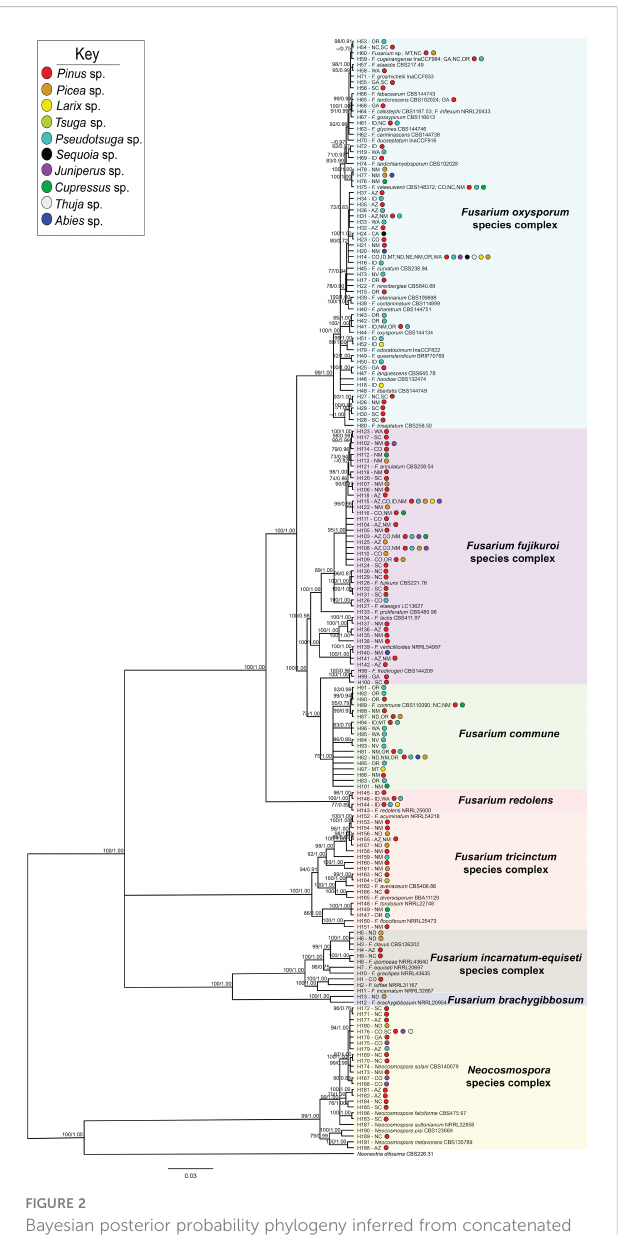
FIGURE 2 Bayesian posterior probability phylogeny inferred from concatenated tef1 a and rpb2 haplotypes from sequences of 325 Fusarioid fungi isolates collected from conifer hosts across the contiguous USA. Node values indicate maximum likelihood bootstrap support based on 1000 pseudo-replicates and Bayesian posterior probability values above 70%/0.75, respectively. The tree is rooted to Neonectria ditissima isolate sequences collected from GenBank (accession # tef1 a : JF735783.1; rpb2 : DQ789798.1). For each haplotype (denoted by H#), states are listed and colored circles indicate the host genera from which the isolates within that haplotype were collected. Fusarioid fungi and species complex haplotype clades are grouped together within colored